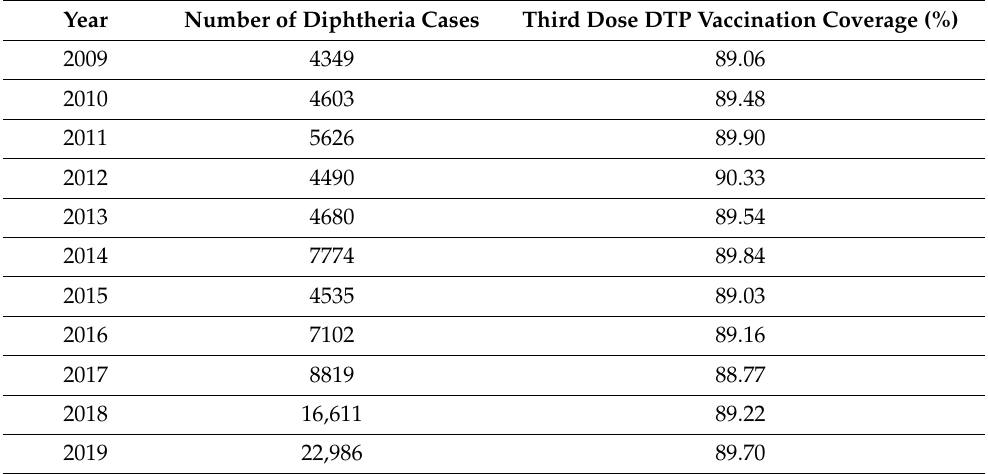
Figure 1. C. diphtheriae infection. Infection pathway by respiratory droplets and pseudo-membrane formation (indicated in yellow) caused by colonization of the upper respiratory tract (figure created with BioRender.com). Table 1. Worldwide cases of diphtheria and vaccination coverage 2009 to